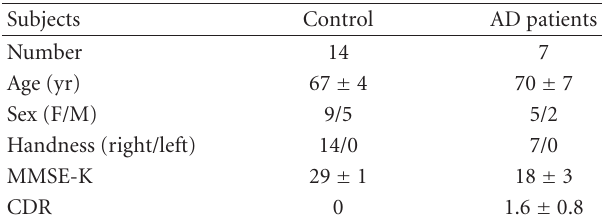
Table 1: Demographic